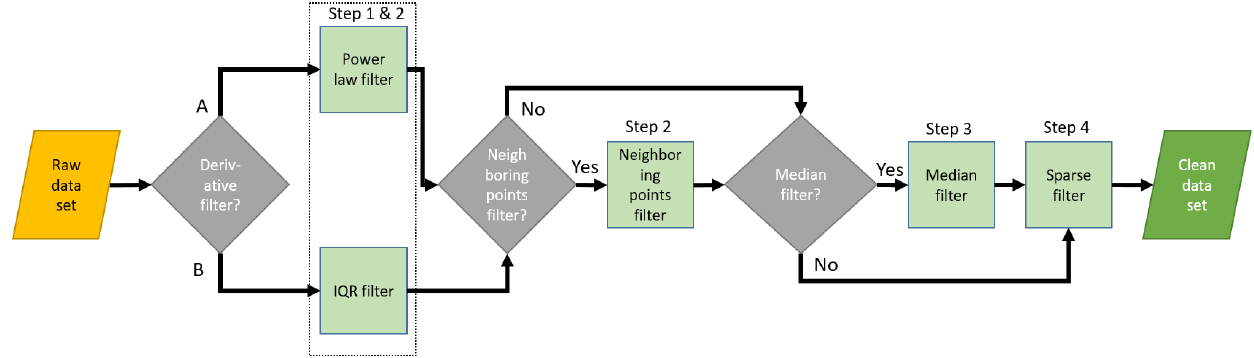
Figure 2. Schematic of the pollution detection algorithm. The key is the power law filter (highlighted in a dotted rectangle), which is followed by a series of steps. The neighboring points and the median filter are optional and can be skipped. Parameters of each step can be adjusted. IQR stands for interquartile range (see Sect. 2.4.1). Table 1. Overview of all filter steps and parameters of the PDA applied to different datasets. Filter step Parameter Particle number Particle size CO